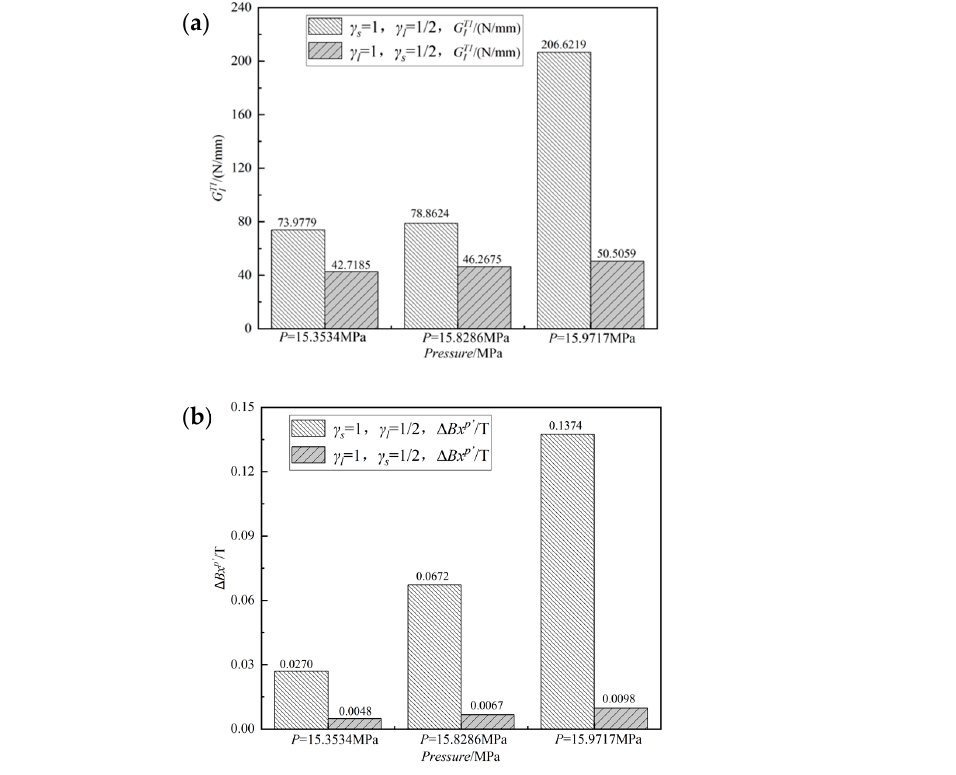
Figure 20. Variations of 𝛾 (cid:3039) and 𝛾 (cid:3046) in the first set of the example. ( a ) 𝐺 (cid:3010)(cid:3021)(cid:2869) − 𝛾 (cid:3039) , 𝐺 (cid:3010)(cid:3021)(cid:2869) − 𝛾 (cid:3046) , ( b ) ∆𝐵𝑥 (cid:3043)’ −